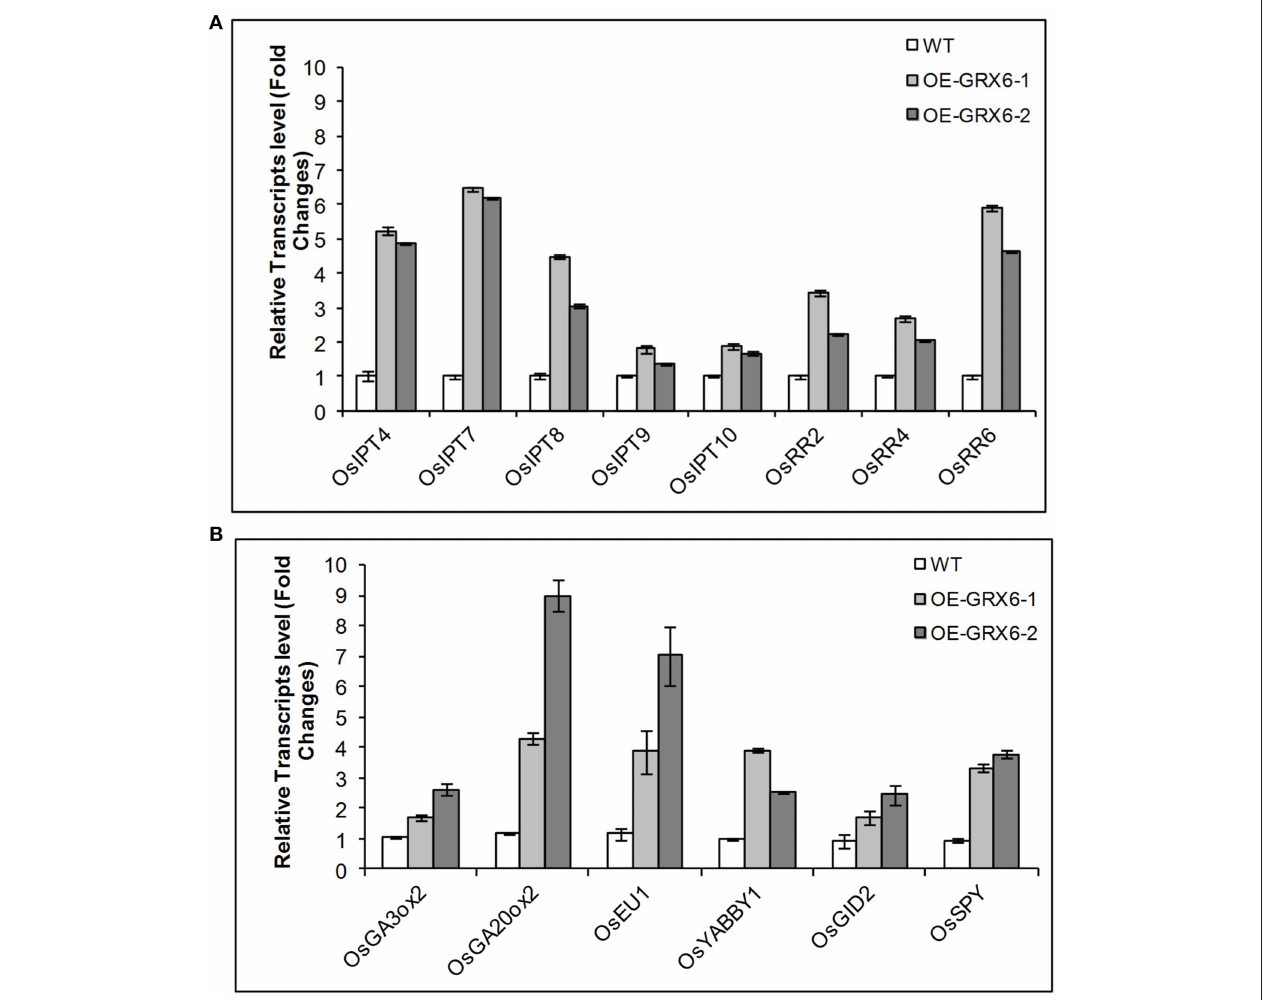
FIGURE 9 | Quantitative relative gene expression of Cytokinin (A) and GA (B) genes in the wild-type rice and the transgenic lines. Fully expanded leaves were collected from 4 weeks old plants growing as described in the Materials and Methods. Data represent the values obtained from three biological replicates relative to the wild type plants as a references. Values are the mean of three biological and three technical replicates ( ± SD).